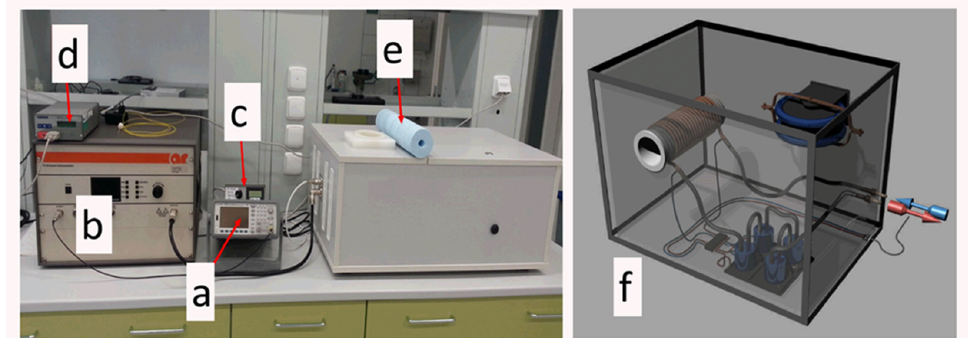
Figure 21. Laboratory device for measuring the heating ability of materials and conducting in vitro and in vivo studies: ( a ) signal generator, ( b ) signal amplifier, ( c ) AMF amplitude meter, ( d ) temperature recorder with fiber optic thermocouples, ( e ) sample holder, ( f ) schematic illustration of a device with a horizontal position of an impedance coil for in vivo study. The measurements were carried out in AMFs with frequency 525 kHz and amplitude